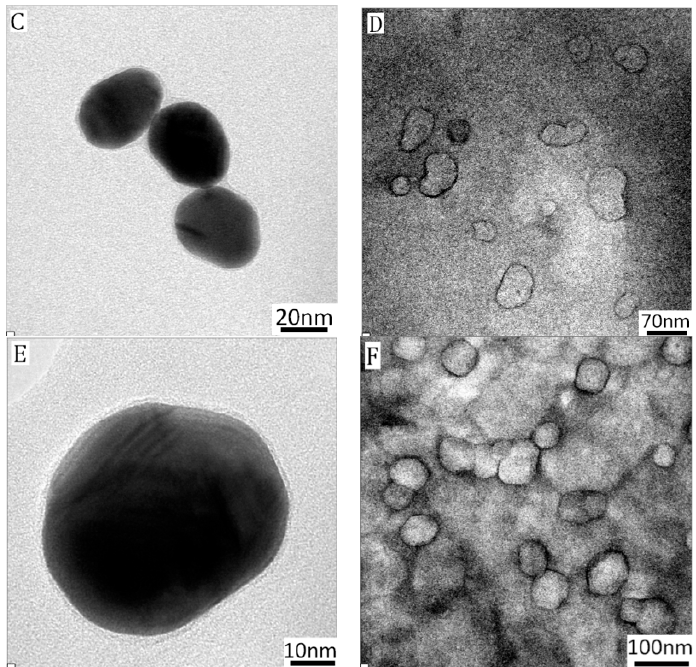
Figure 4. TEM images of PIC-@-Au 10 NPs ( A ) and PICsome 10 ( B ); PIC-@-Au 40 NPs ( C ) and PICsome 40 ( D ); PIC-@-Au 60 NPs ( E ) and PICsome 60 ( F ). The number in subscript corresponds to the size of the Au template.